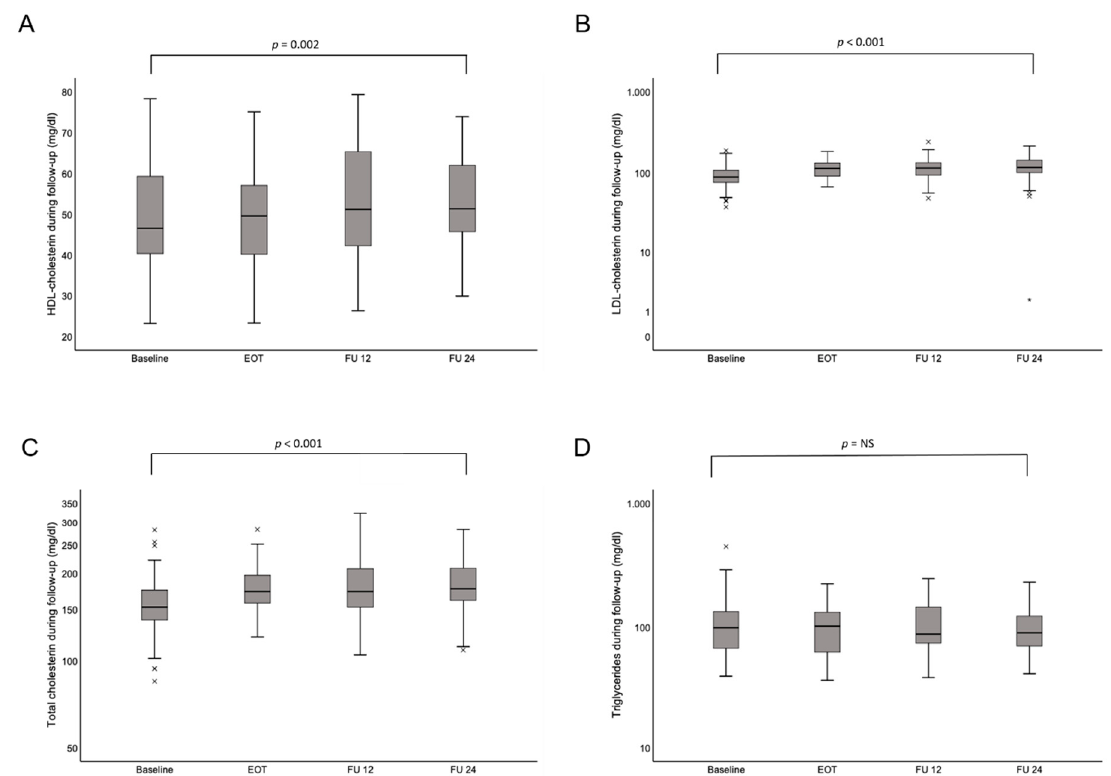
Figure 2. Changes in lipid parameters over time, during and after DAA therapy. ( A ) HDL-cholesterin, ( B ) LDL-cholesterin, ( C ) total cholesterin, and ( D ) triglycerides. The top and bottom of the boxes are the first and third quartiles, respectively. The middle line through the middle of each box represents the median. × represents mild outliers which lie between 1.5 and 3.0 times the IQR. * represents extreme outliers which lie more than 3.0 times the IQR. Abbreviations: EOT, end of treatment; FU12, 12 weeks; IQR, interquartile range.